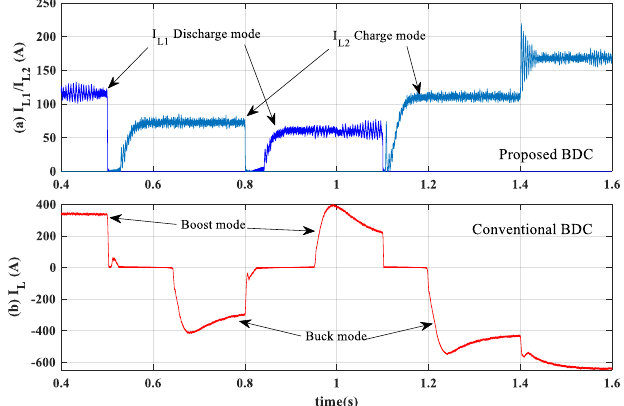
Figure 18. Converter response to pulsed DC load change for Case I with voltage control mode.